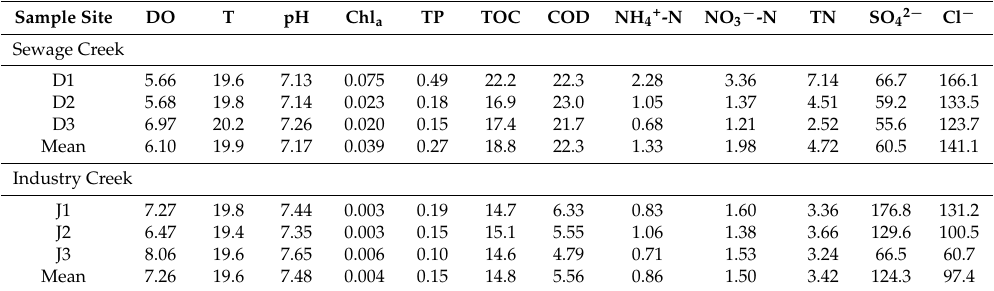
Table 3. Water quality of the creeks (mg/L).